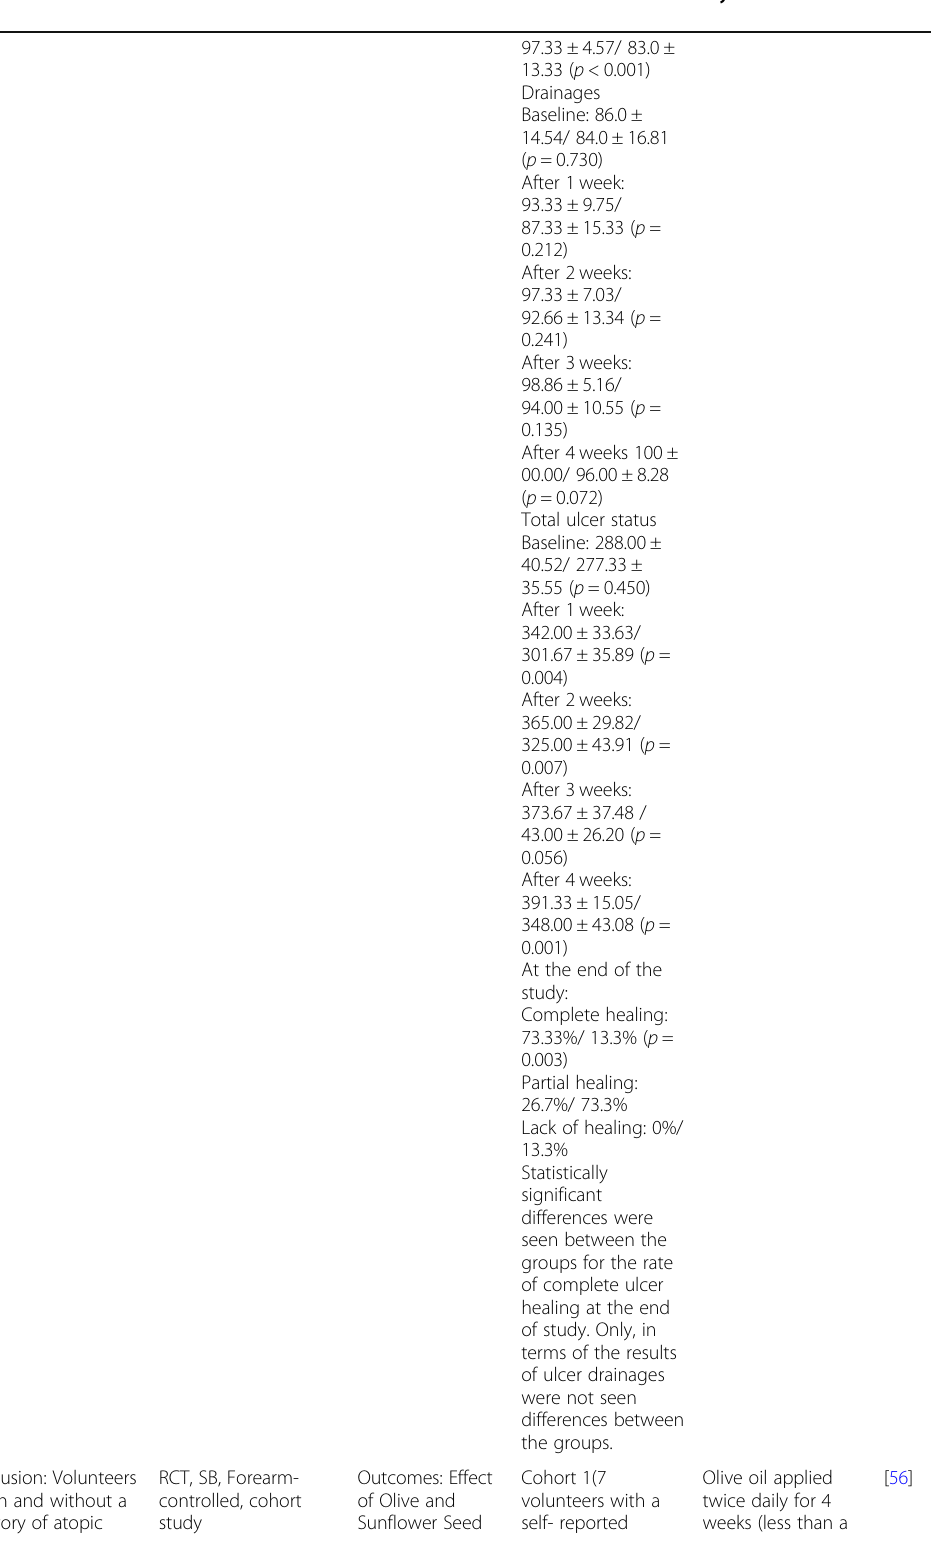
Table 4 Clinical trials of the traditional plants used for skin problems in Turkey (Continued) Study Patient